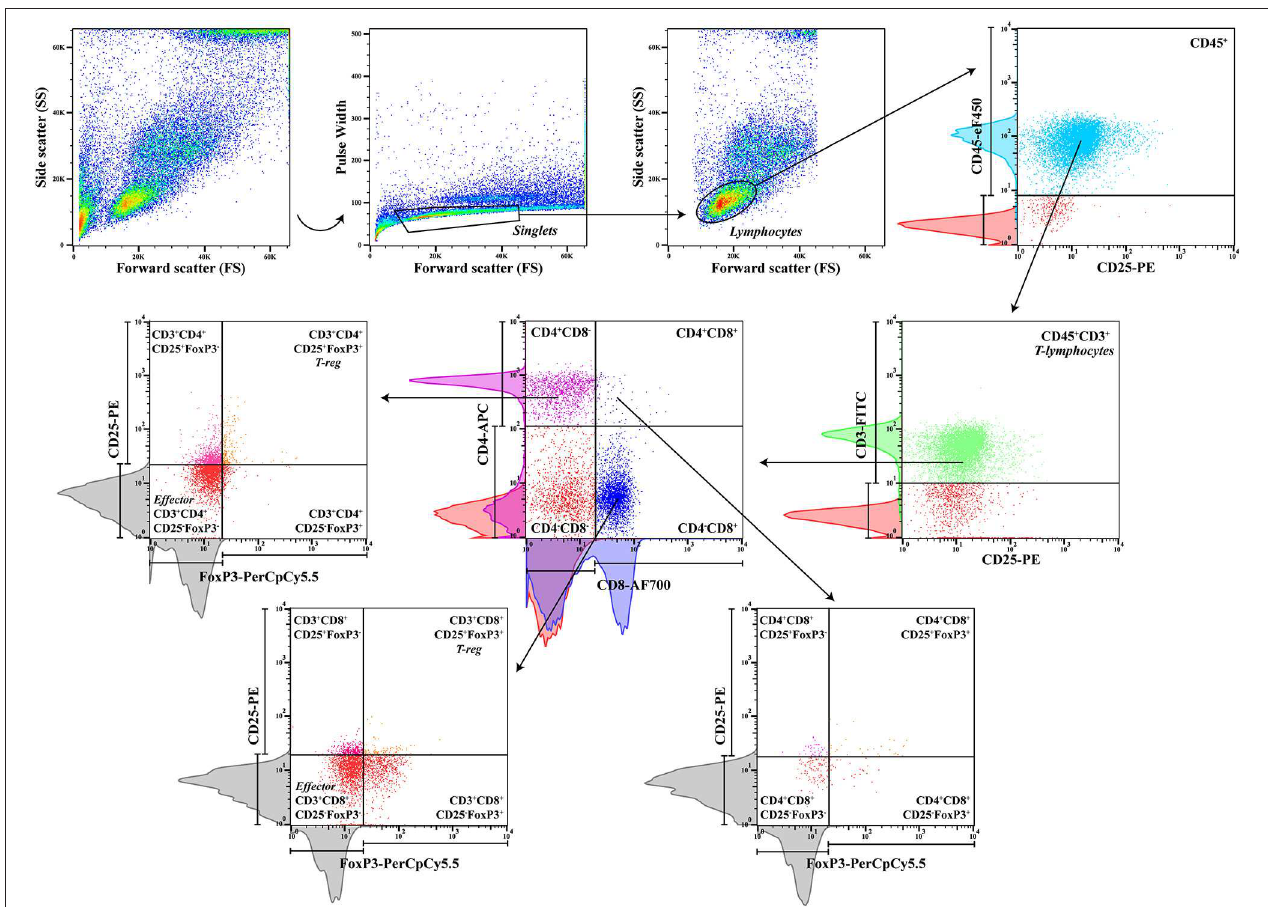
FIGURE 2 | Gating strategy. Peripheral blood sequential gating strategy for a panel of six antibodies to identify the different cell subpopulations after doublet exclusion. CD45, a pan-leukocyte marker, and CD3, a T-lymphocyte specific marker, were used to define the T-lymphocyte population, with posterior separation of CD4 + and CD8 + cells, CD4 + CD8 + double-positive T cells, and subsequent regulatory CD25 + FoxP3 + and effector CD25 − FoxP3 − cells. Red histograms from unstained control samples and colored histograms from single-stained control samples were used to define the sequential gating, along with gray histograms from fluorescence minus one (FMO) controls to gate for rare cells (CD25 + FoxP3 + ).